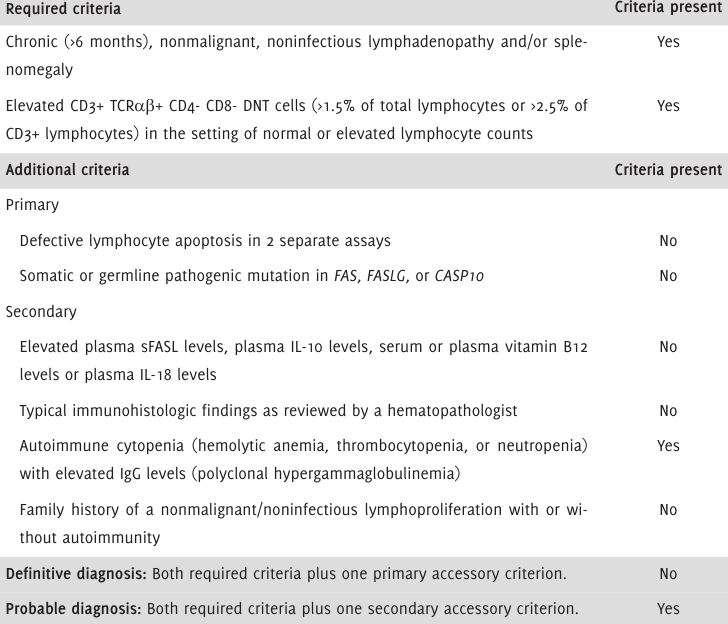
Table 3. Revised Diagnostic Criteria for ALPS Based on the First International ALPS Workshop of 2009, Showing Criteria Fulfilling a Probable ALPS Diagnosis in this